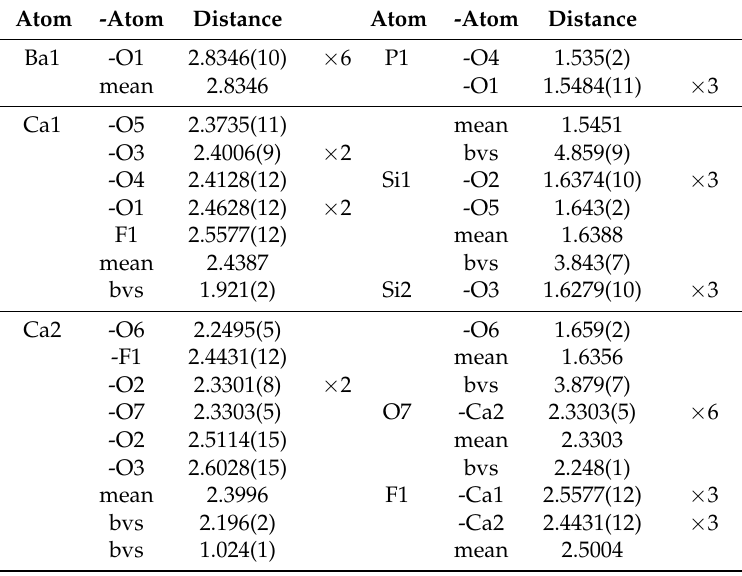
Table 5. Selected interatomic distances (Å) for